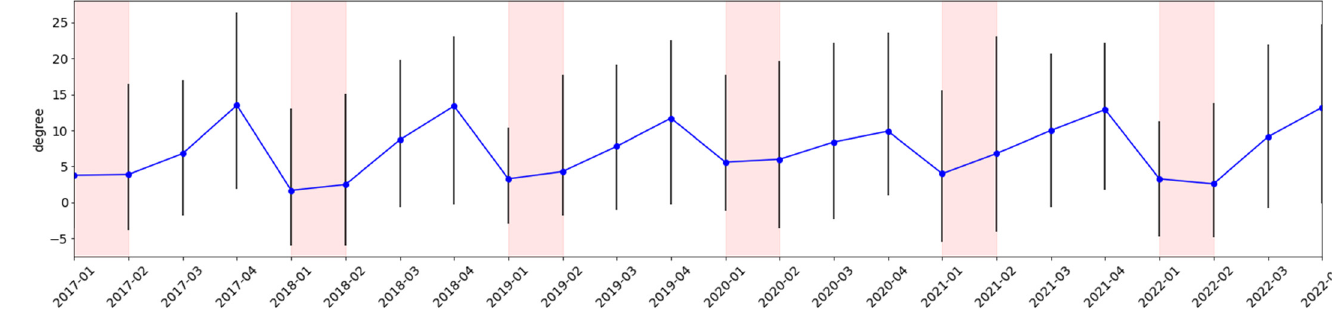
Figure 7. The temperature in Celsius in the study area from 2017 to 2022. The vertical line in black represents the maximum and minimum temperature. We highlight the case of January and February, because the vegetation needs time to change.